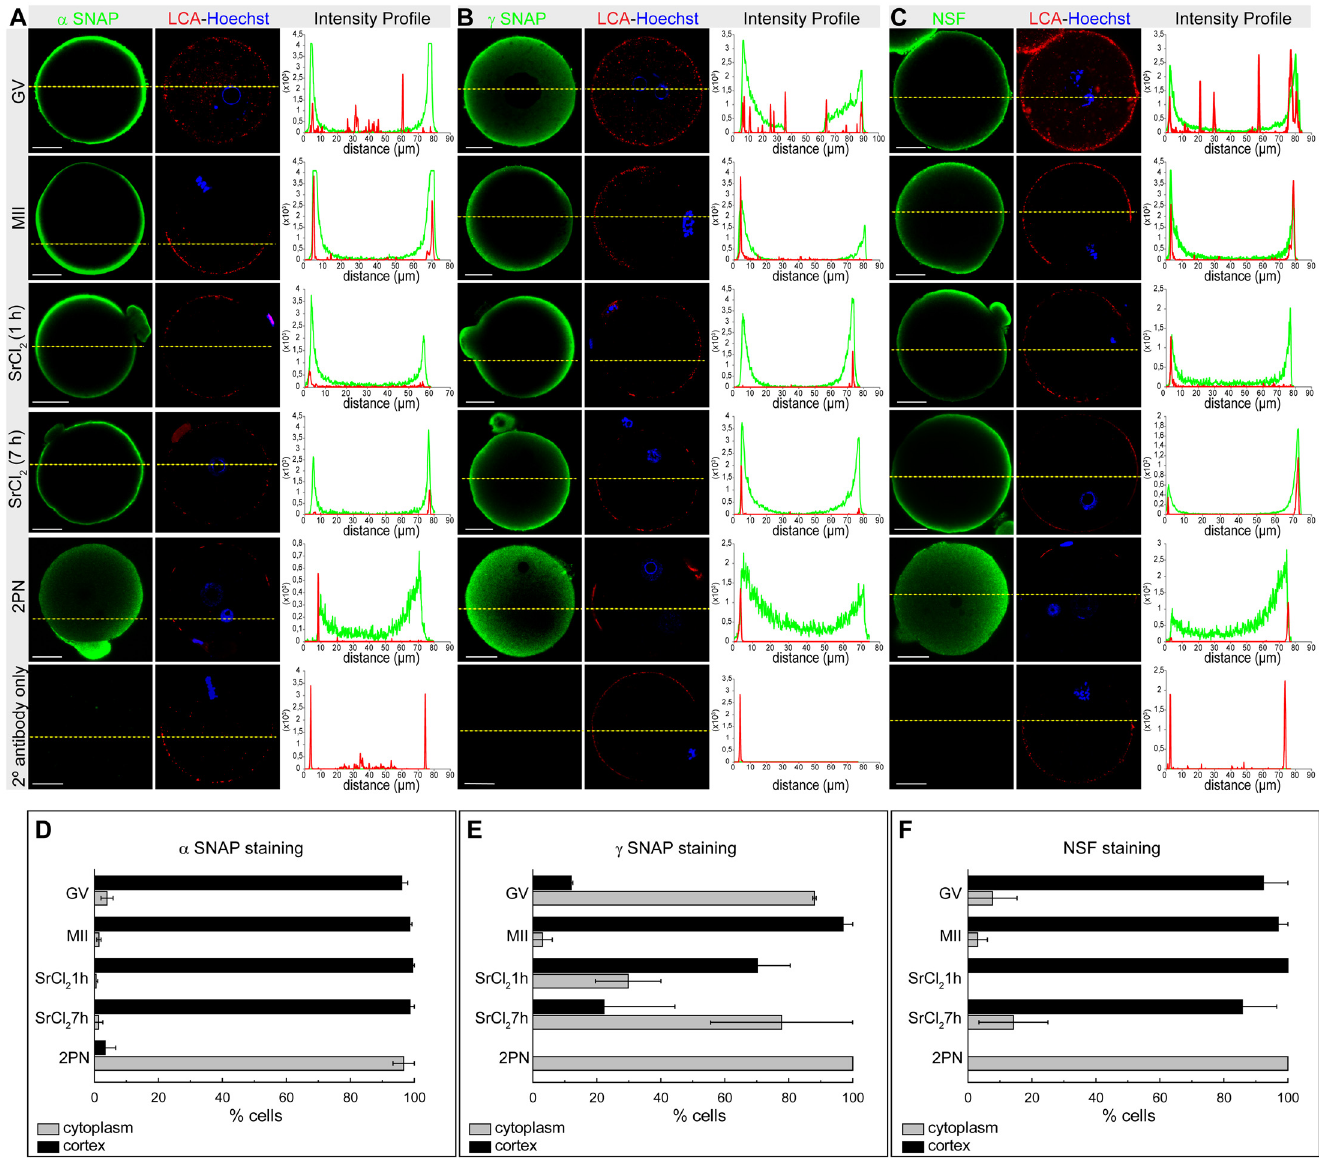
Fig 3. α -SNAP, γ -SNAP, and NSF localization during meiotic maturation and MII oocytes activation. α -SNAP (left panel), γ -SNAP (middle panel) and NSF (right panel) were immunodetected at different stages: GV-intact oocytes (GV), MII oocytes(MII), parthenogenetic activated MII oocytes with 10mM strontium chloride during 1 or 7 h post activation (SrCl 2 (1h) and (7h), respectively), and two pronucleus (2PN) embryos after in vitro fertilization. Green, positive staining for primary α -/ β -SNAP, γ -SNAP or NSF antibody detected by secondary antibodies conjugated to DyLight 488; red, cortical granules stained with LCA-Rhodamine; blue, DNA labeled with Hoechst 3342. A-C , panels show the fluorescence intensity profiles for α -SNAP, γ -SNAP and NSF (green) and cortical granules stained with LCA-Rhodamine (red). Fluorescence intensities were measured along dashed lines traced in each panel. The intensities of α - SNAP, γ -SNAP and NSF are indicated by green lines, and the intensity of cortical granules is indicated by red lines. Scale bar: 20 μ m. D - F , cortical and cytoplasmic patterns of protein distribution. Cortical region was defined as the region of 10 μ m thickness from the oocyte plasma membrane towards the oocyte centre. Those cells in which fluorescence decay at 10 μ m were considered to present a cortical staining, and those cells which present high fluorescence at 10um towards the center and beyond were considered to present cytoplasmic staining. Percentage analysis was assessed. Number of analyzed cells for α -SNAP, γ -SNAP and NSF were, respectively: GV = 85,51,32; MII = 138,37,35; MII SrCl 2 1h = 101, 36, 30; MII SrCl 2 7h = 35, 27, 33; IVF = 13, 6, 9.